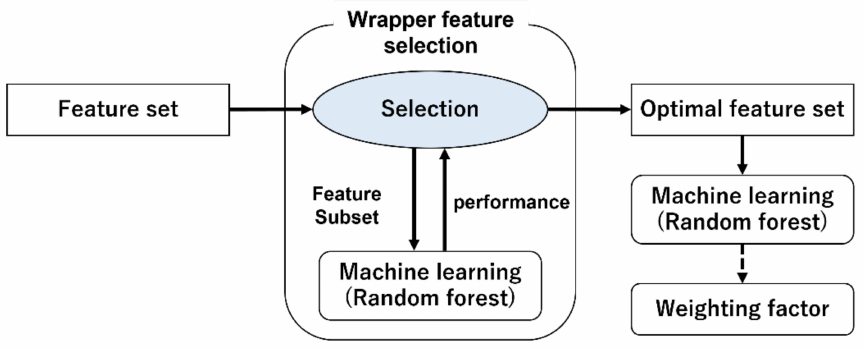
Figure 4. Outline of wrapper feature selection